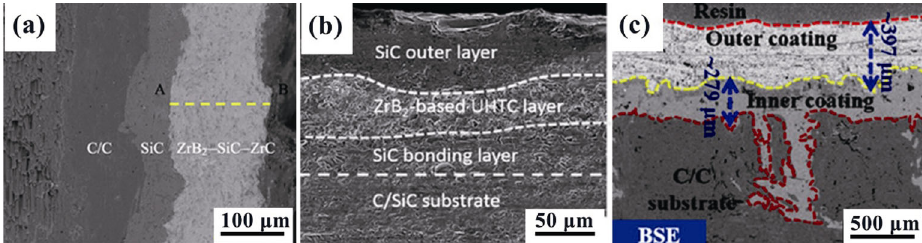
Fig. 34 Typical morphologies of multiphase UHTC/silicide multilayer coatings: SiC/ZrB 2 –ZrC–SiC [293] (a), SiC/ZrB 2 – SiC/SiC [336] (b), and HfB 2 –MoSi 2 /SiC–Si [324] (c). Reproduced with permission from Ref. [293], © Elsevier B.V. 2016;